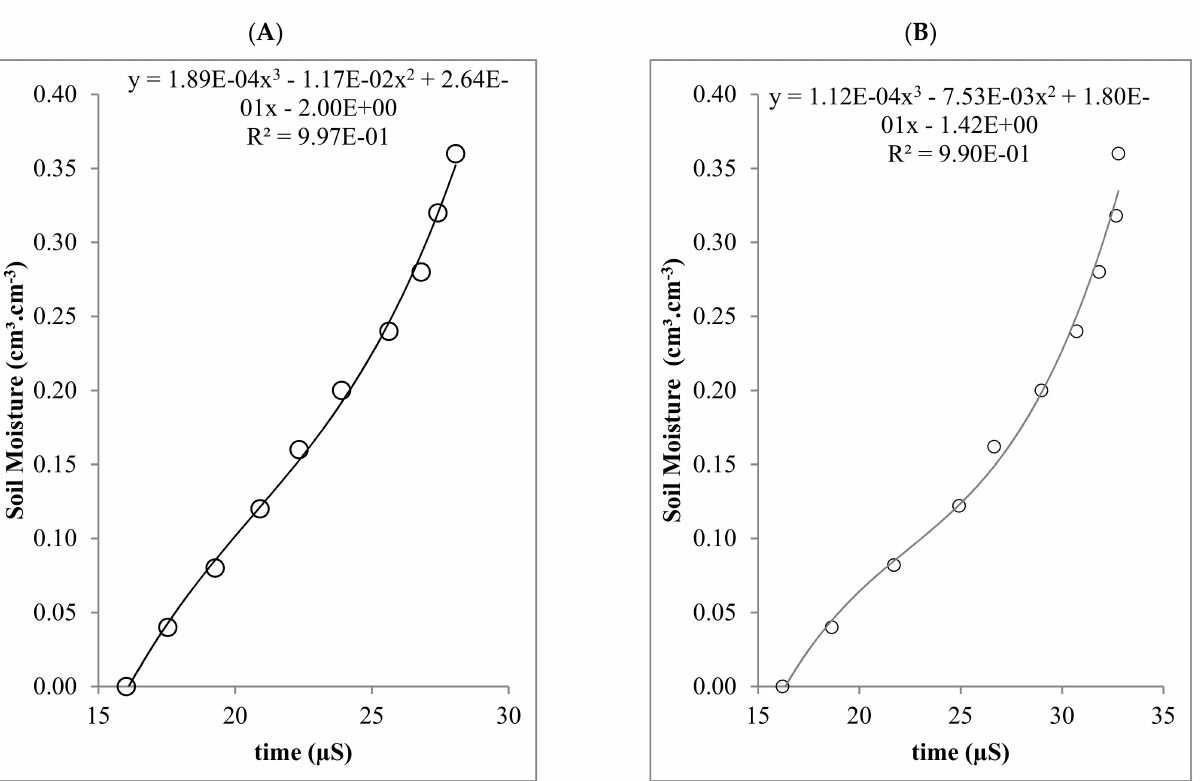
Figure 3. CS616 sensor calibration in the Caatinga ( A ) and Pasture ( B )